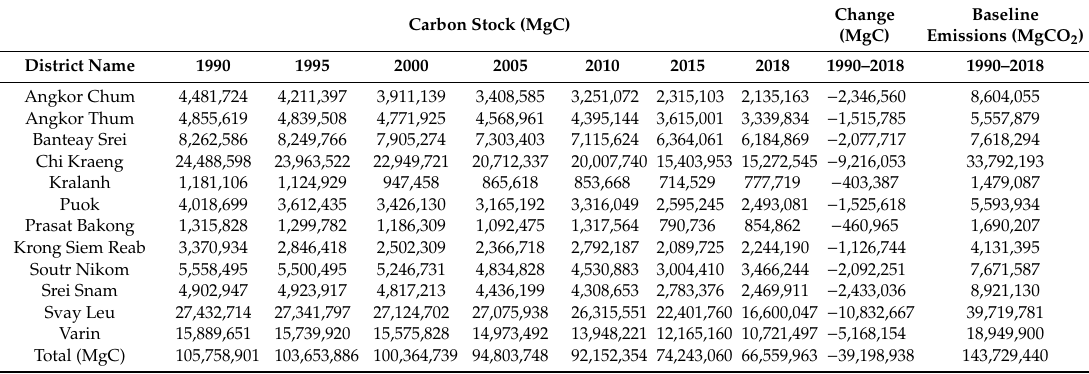
Table 9. District level forest carbon stock (MgC) changes and baseline emissions (MgCO 2